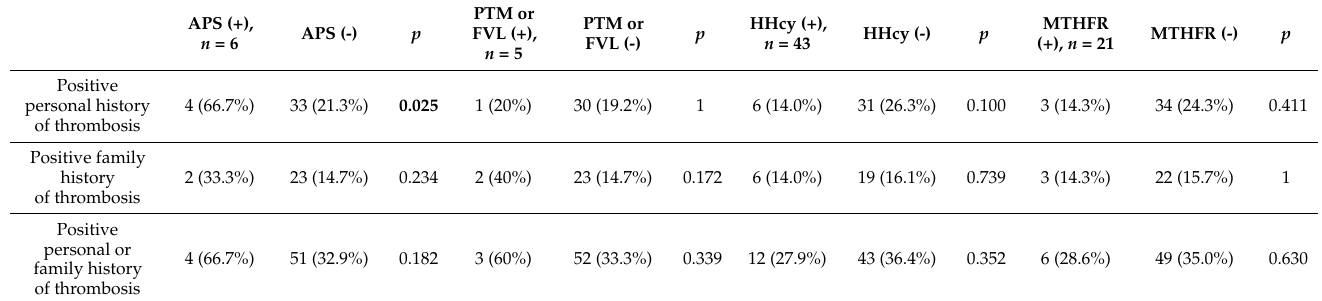
Table 2. Association of personal and family history and thrombophilia diagnosis.